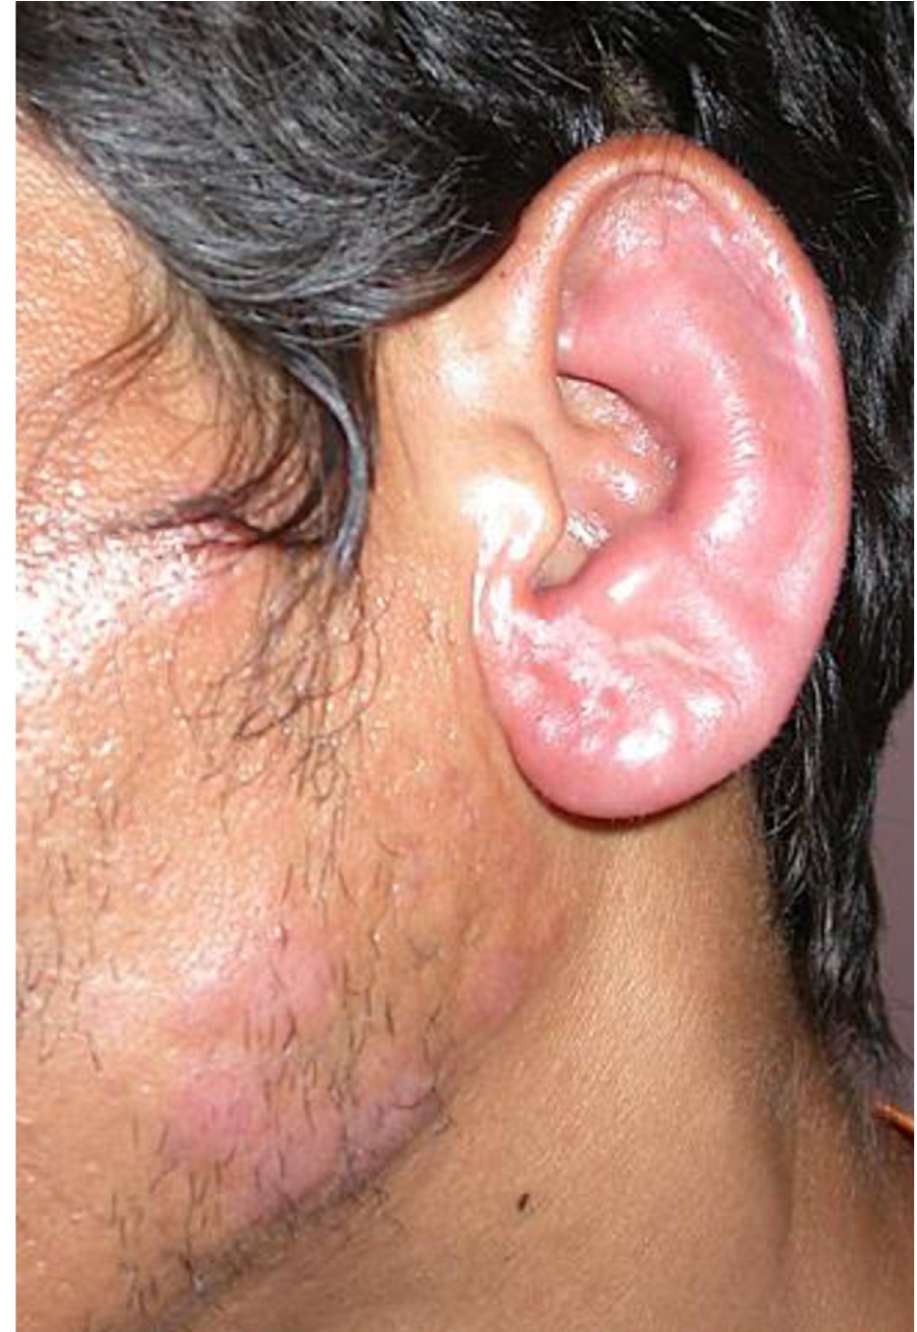
Fig 3. IRIS type 1 after introduction of HAART in patient 4: BT leprosy on the left ear and cheek with hypertrophy of the great auricular nerve. BB leprosy, one (1.4%) of LL and one (1.4%) of neural leprosy. Data were not available for five patients (6.8%). According to the WHO classification, 39 (53.4%) patients had a PB leprosy and 34 (46.6%) had MB leprosy.